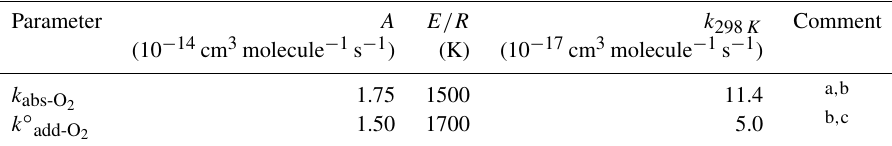
) and the reference rate coefficient 2 ). 2